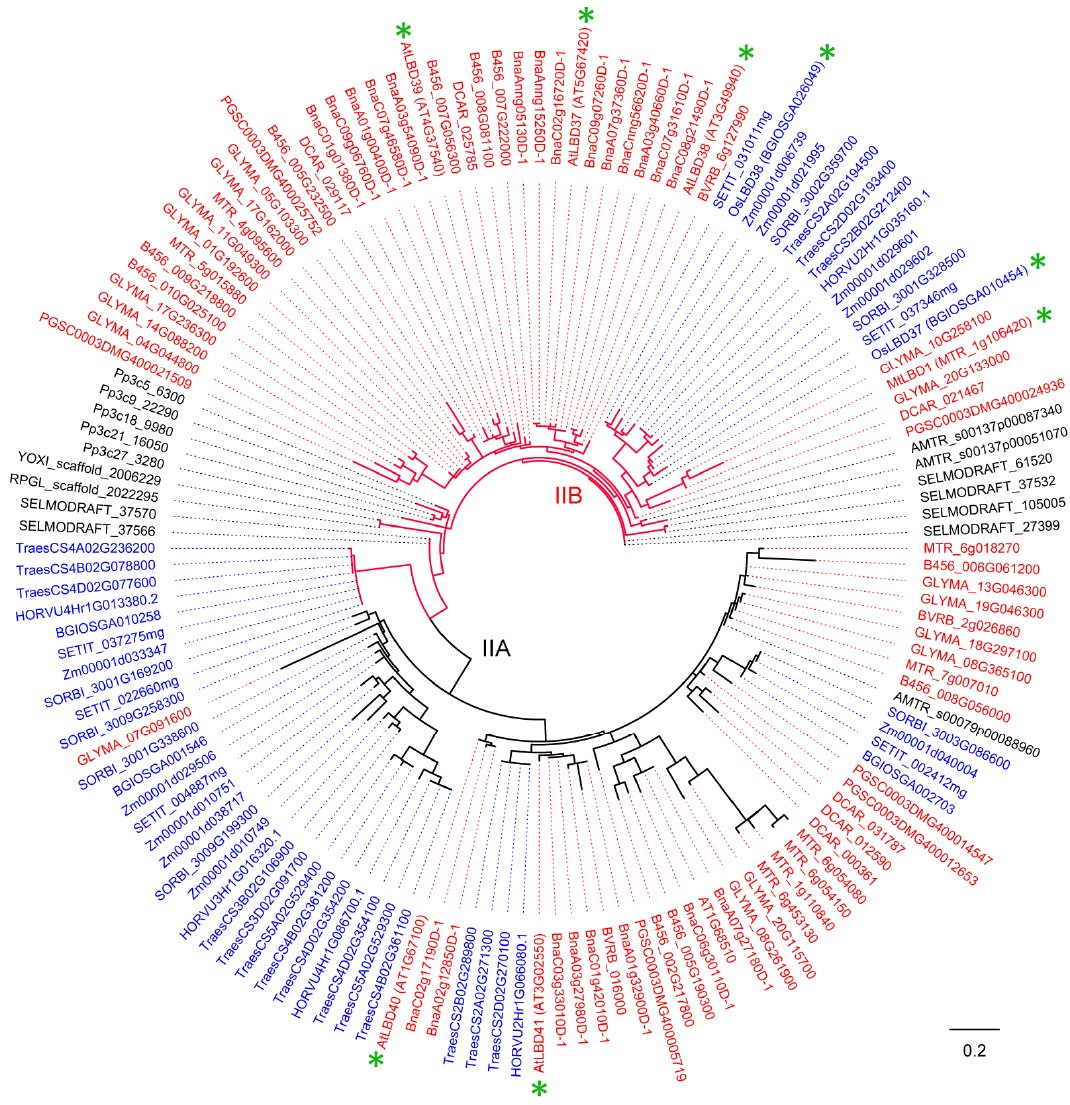
Figure 8. Phylogeny of LBD proteins from Class II in 18 species. This phylogeny was reconstructed using Class II LBD proteins identified in Figure 1 and according to the same method described in Figure 1 legend. “*” means functionally characterized LBD protein in Table 2 (Gene ID is in brackets for LBD proteins of 18 species, species name is in square brackets for LBD proteins of other species). LBD proteins of eudicots, monocots, and other plant species are marked in red, blue and black, respectively. Branch color corresponds to that in Figure